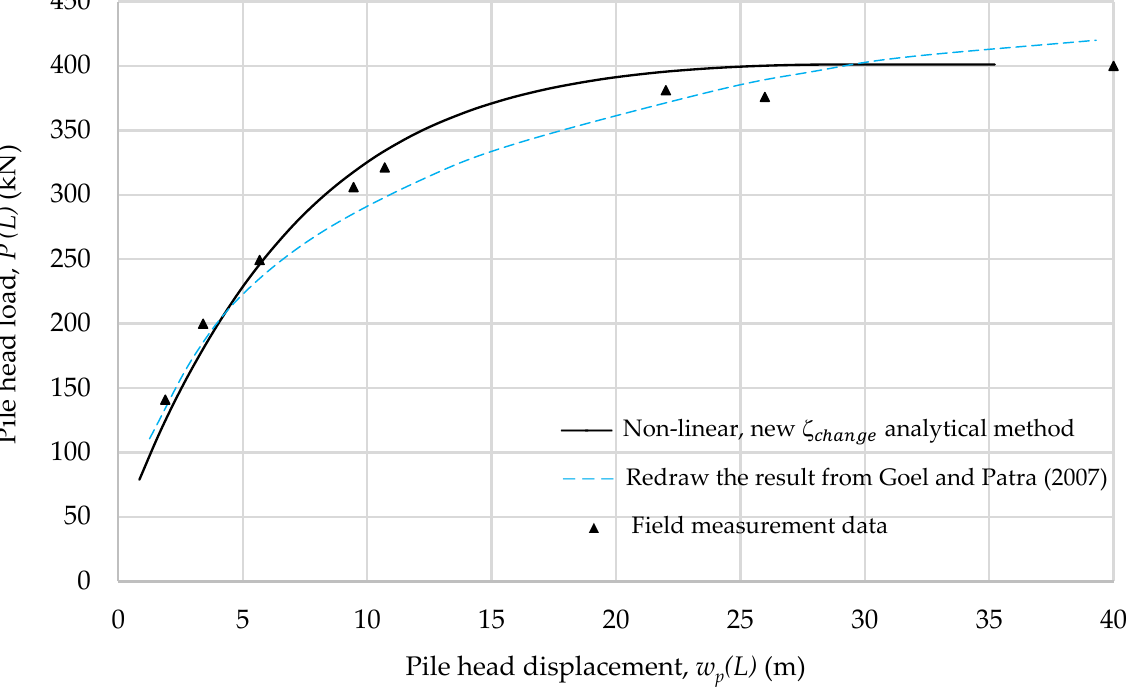
Figure 23. Further improvement by using a nonlinear hyperbolic analytical model.